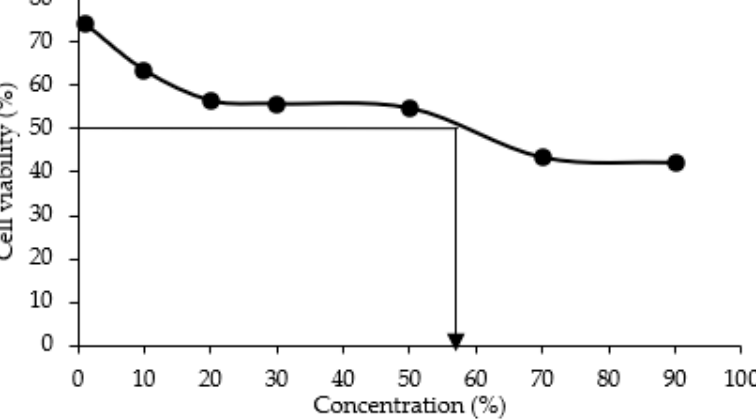
Figure 5. Effect of CCG-NP on 3T3 cells after 72 h of exposure.